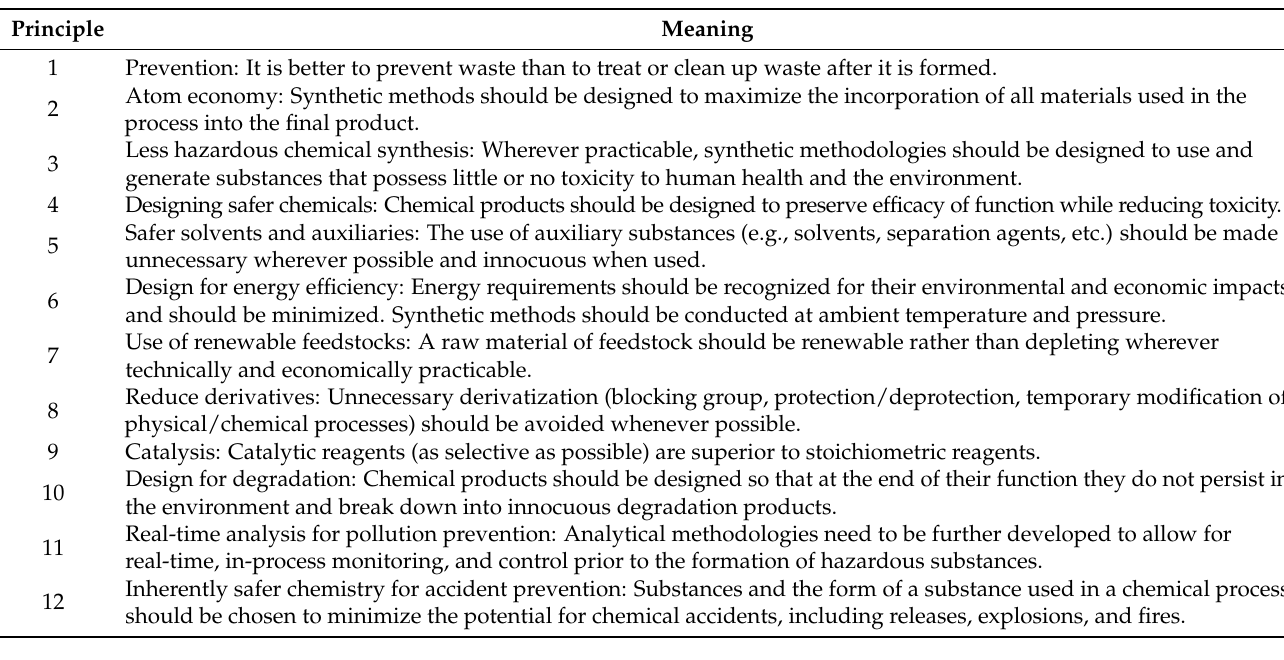
Table 1. The 12 Principles of Green